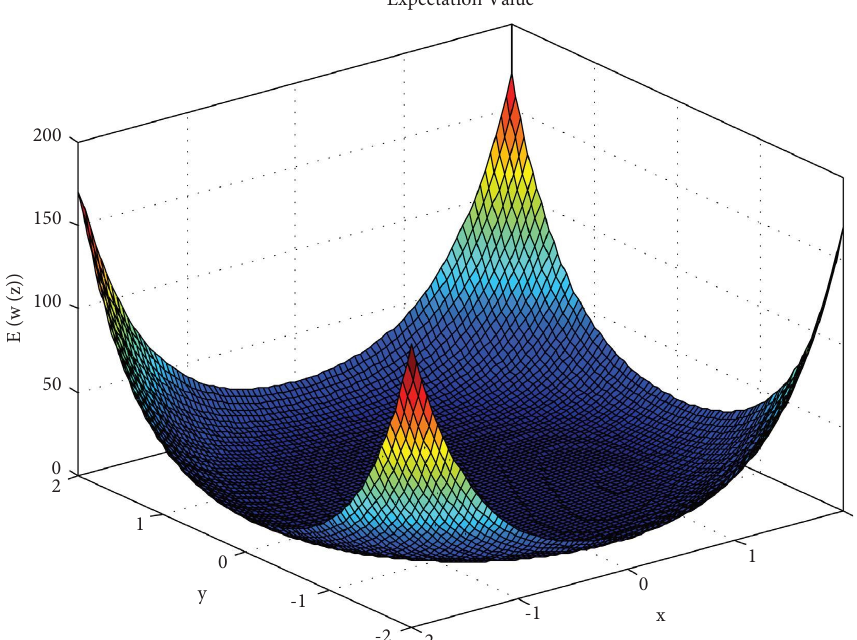
Figure 7: Expected value of equation (38) for α � 1, β � 2.